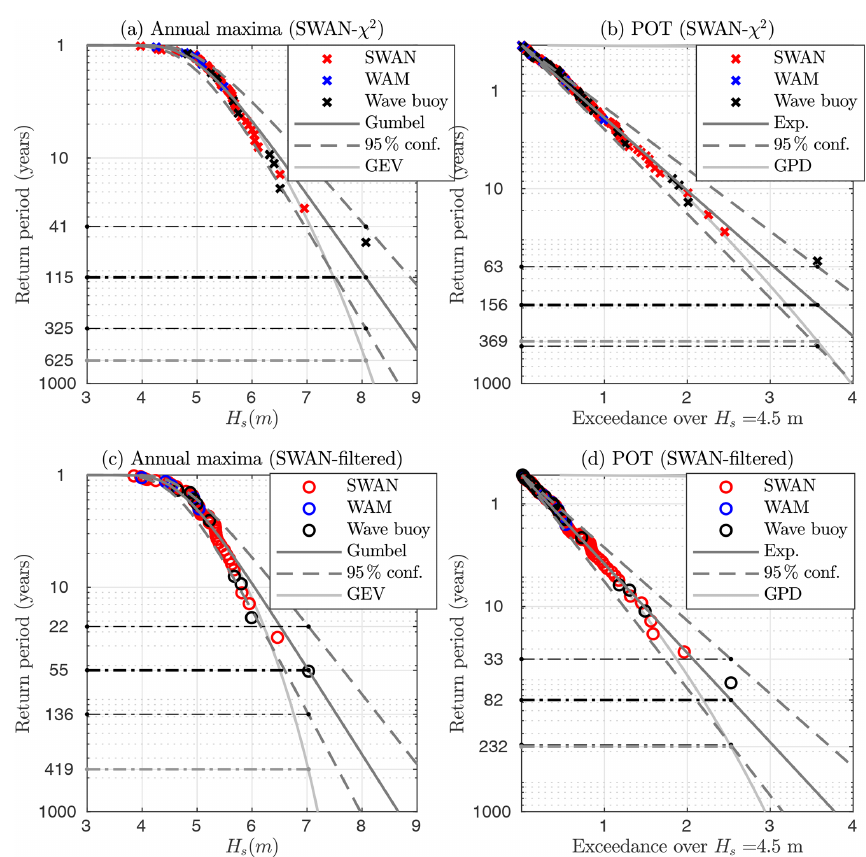
Figure 7. Fits to annual maxima and POT values from the Bothnian Sea wave buoy. (a, b) Original observations and model values with an added synthetic χ 2 variability. (c, d) Original model data and low-pass-filtered observations. A single realisation of added χ 2 variability being close to averages of Table 3 has been chosen. Illustrations of other data combinations and thresholds are available as Supplement.